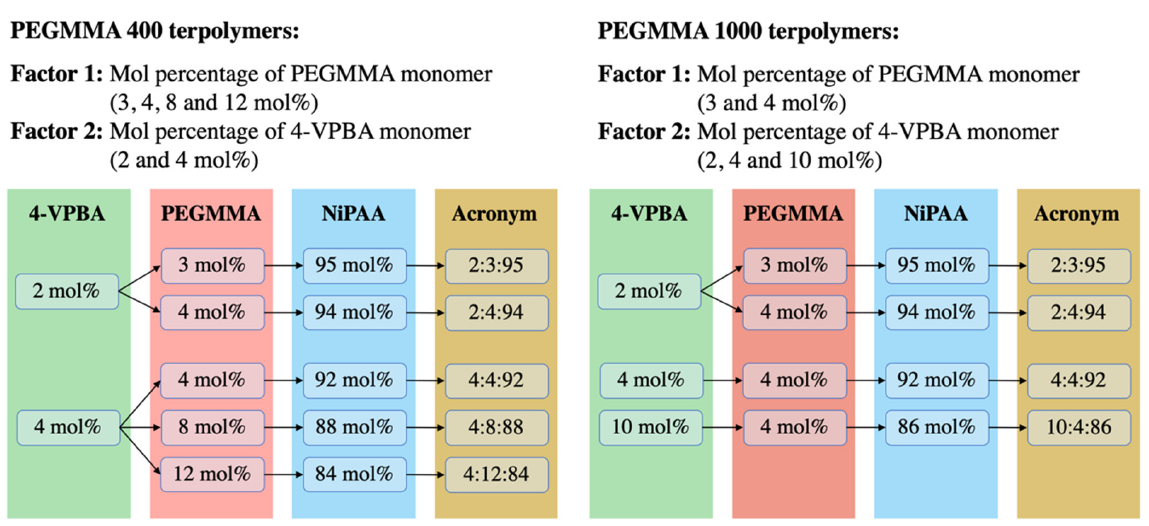
Figure 1. Factors and levels considered in 4-VPBA:PEGMMA:NiPAAm terpolymers experimental design.